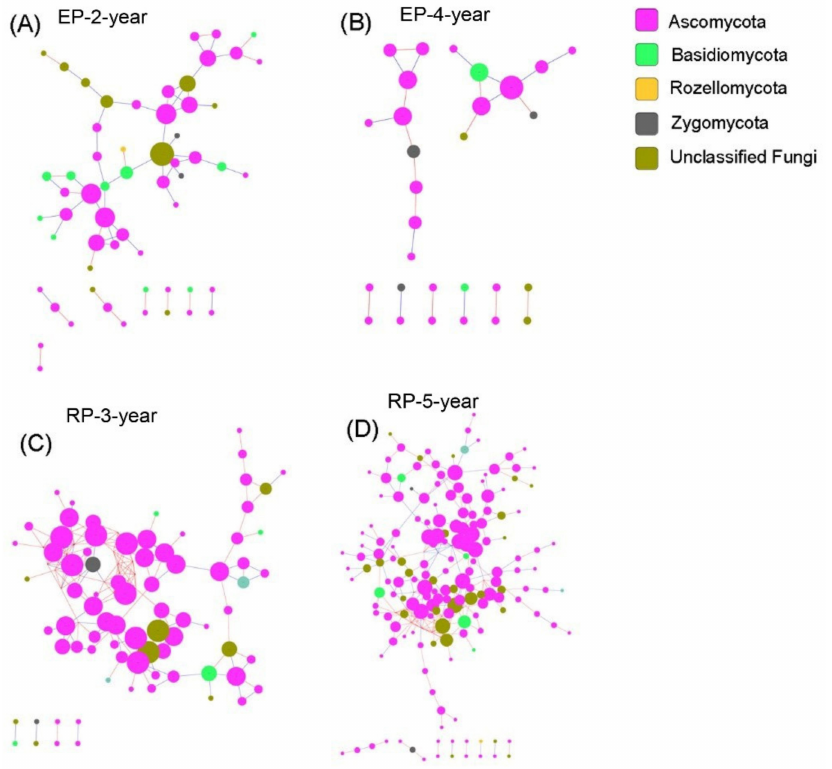
Figure 7. Soil Fungal species co-occurrence networks in the studied plantations. ( A , B ) Structure of the networks in 2-year-old and 4-year-old Eucalypt plantations (EP-2-year and EP-4-year). ( C , D ) Structure of the networks of 3-year-old and 5-year-old Rubber plantations (RP-3-year and RP-5-year). The taxonomic a ffi liation of each OTU is specified to phylum, using node color, and the node size is proportional to its connectivity (i.e., degree). The red lines between each two-node structure indicate positive interactions, while blue ones indicate negative